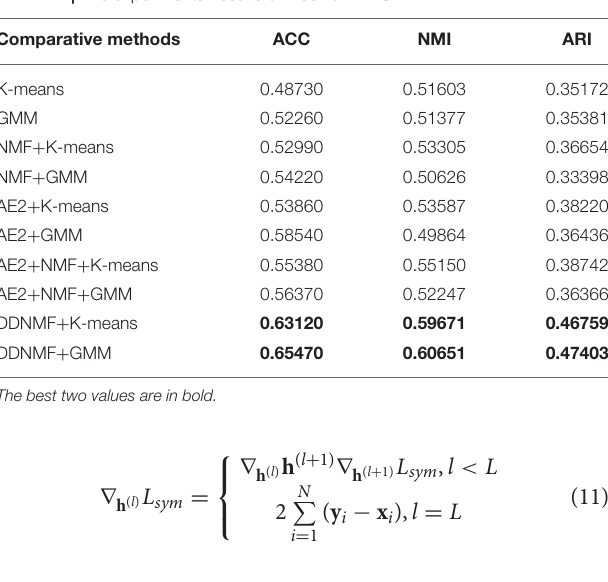
TABLE 2 | The experimental results on FashionMNIST.